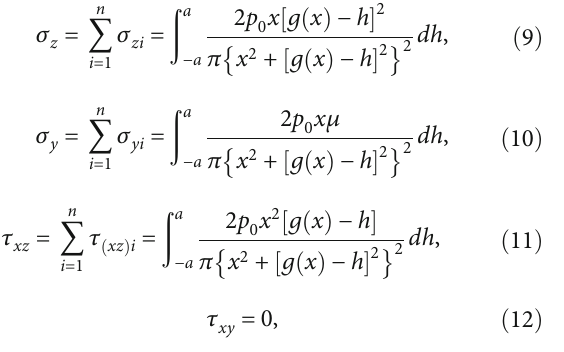
Figure 8: Failure envelopes of soil under di ff erent anisotropy coe ffi cients ρ